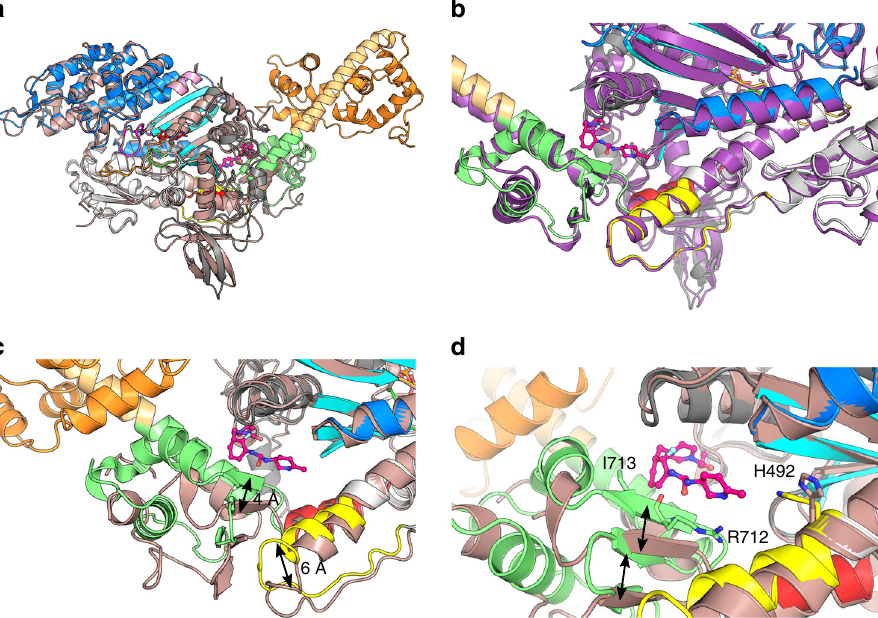
Fig. 2 Binding of OM stabilizes a speci fi c primed position of the myosin lever arm and does not affect the motor domain conformation. a The features of the motor domain including the position of the subdomains (Nter ( grey ), U50 ( blue ), L50 ( white )) and key connectors are similar for the OM-S1-PPS ( multi-colored ) and the APO-MD-PPS ( pink ) structures. b Superimposition of the OM-S1-PPS ( multi-colored ) structure with the Argopecten skeletal myosin II in the PPS state (1QVI 13 , purple ). c Comparison of the relay and the converter in the APO-MD-PPS structure ( pink ) and the OM-S1-PPS ( multi-colored ). The relay ( yellow ) is displaced by ~ 6 Å, and the converter subdomain ( green ) is rotated (15°) and translated (~ 4 Å). Overall, OM binding stabilizes a conformation of the converter that forms a speci fi c “ PPS ” allosteric binding site for OM and maintains the converter in a primed position. d Detail of the OM “ PPS ” binding pocket. Closure of the allosteric site ( black arrows ) stabilizes interactions between OM and converter residues, such as Arg712 and Ile713 as well as His492 which adopts a new conformation to interact with OM